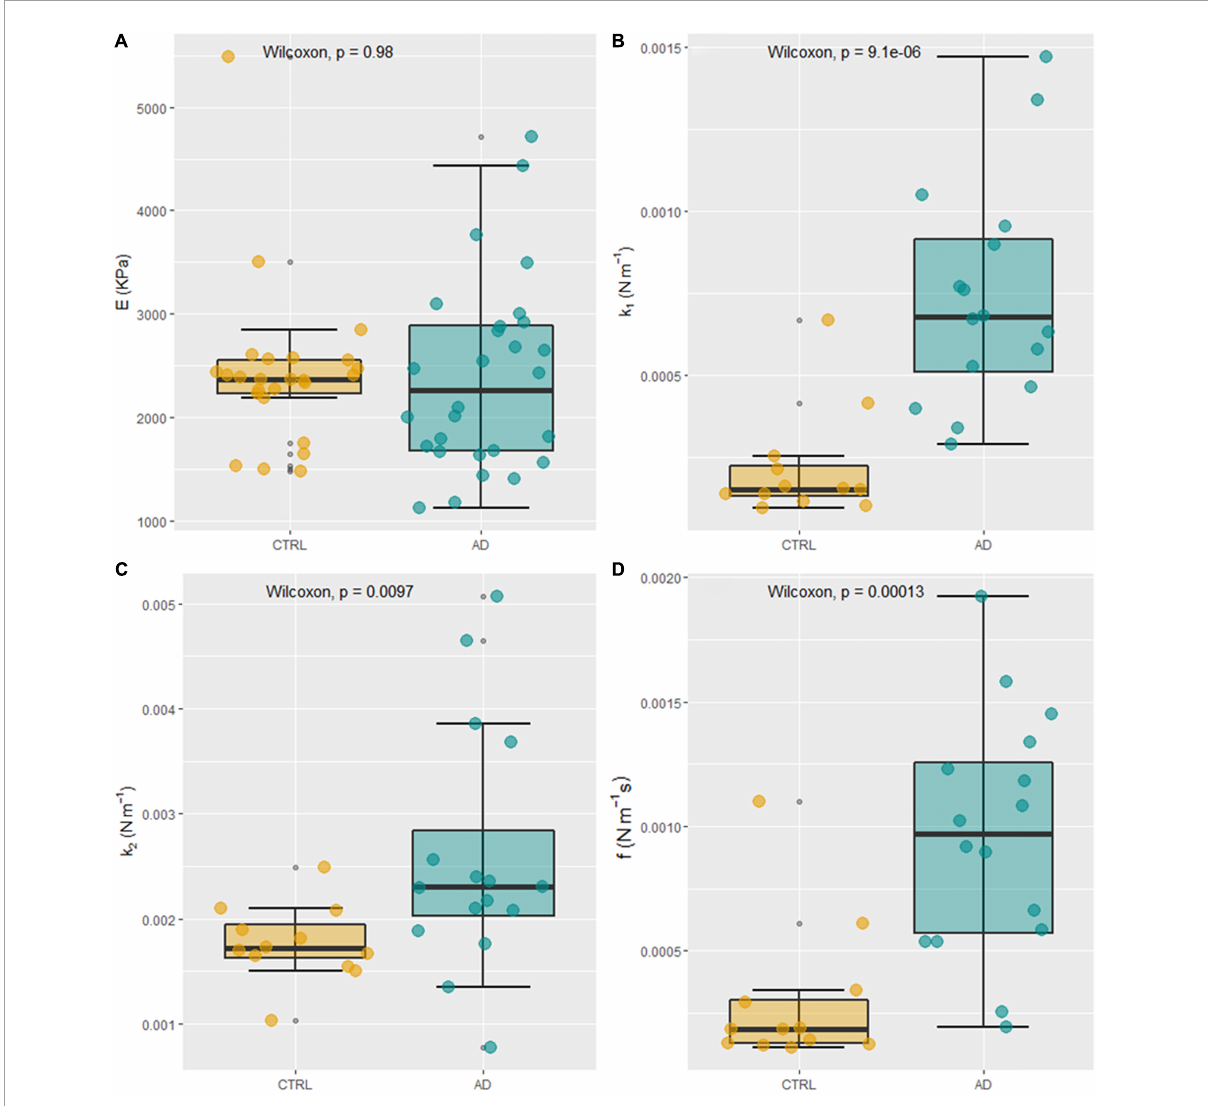
FIGURE3 Box plot analysis of average E -values for control and pathological subjects (A) . Box plot analysis of mechanical parameters obtained from the standard linear solid (SLS) model (B–D)